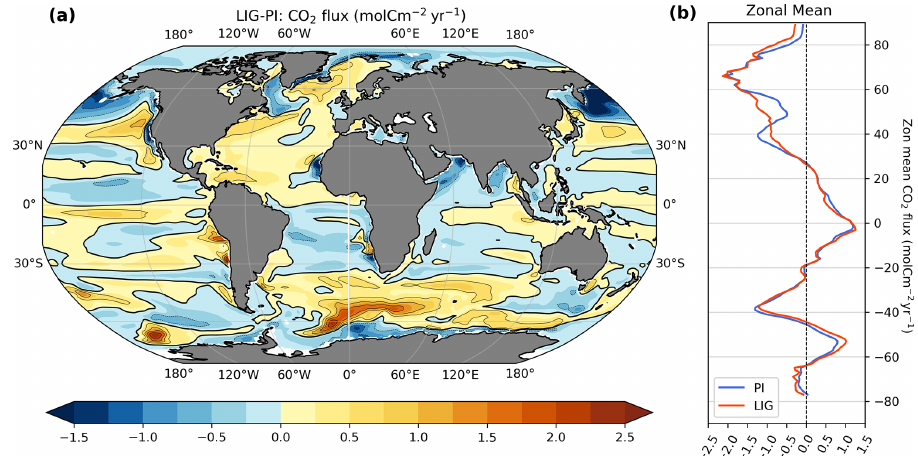
Figure A2. (a) Annual mean air–sea CO 2 flux (molCm − 2 yr − 1 ) for LIG − PI. Red colours indicate outgassing of CO 2 from the ocean, and blue colours indicate uptake by the ocean. Thick black lines show the zero line contour. (b) Zonal mean CO 2 flux (molCm − 2 yr − 1 ) for PI (blue) and LIG (red).